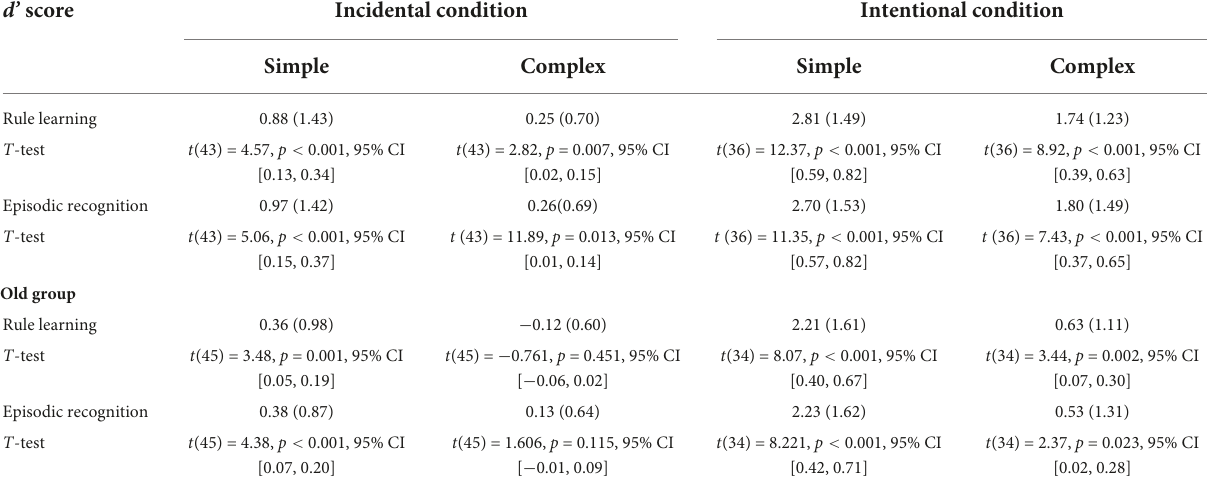
TABLE 2 Mean rates (SD) for d’ scores and t -tests between hits and FA.